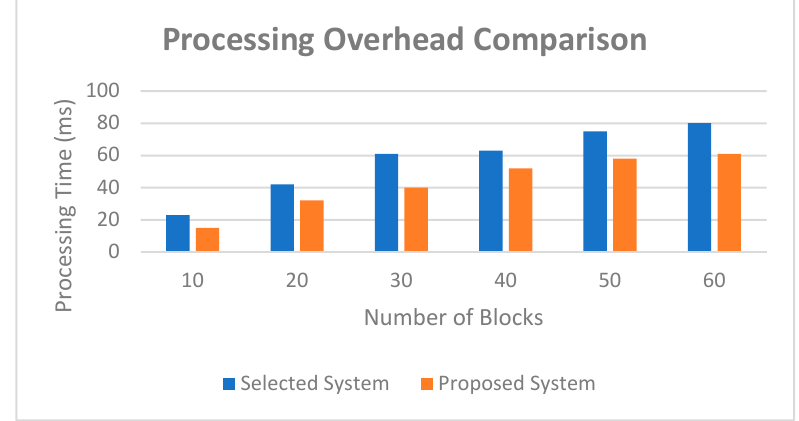
Figure 18. Performance analysis graph of processing overhead comparison.